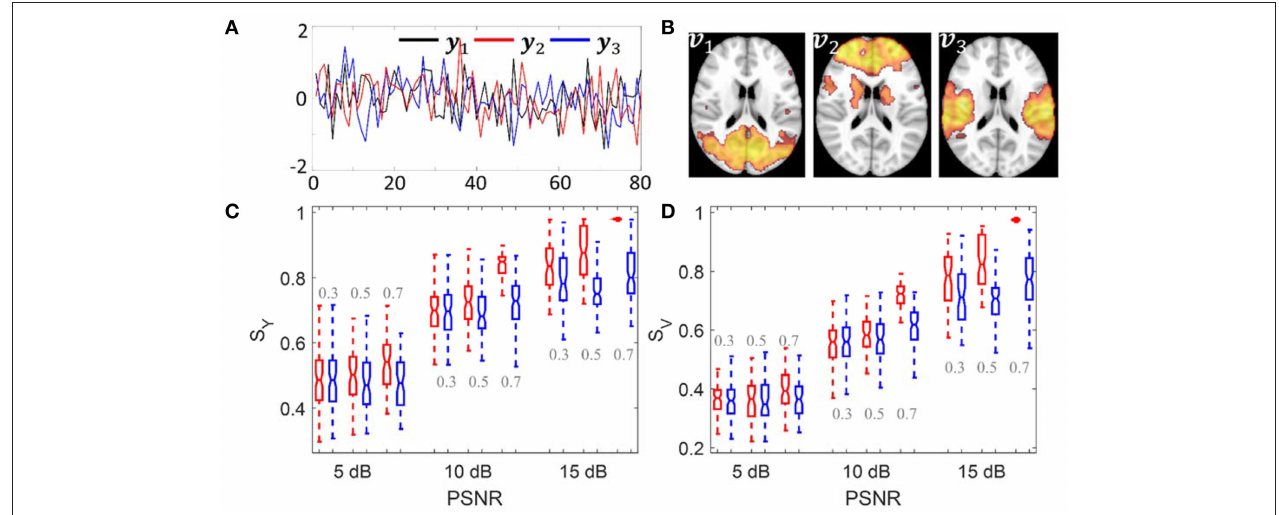
FIGURE 3 | Simulation 1: Comparison of sPCA and PCA. (A) Simulated principal component scores Y = [ y 1 , y 2 , y 3 ]. (B) The spatial maps V = [ v 1 , v 2 , v 3 ] corresponding to the scores with 70% voxels having zero values. Simulated data were generated 100 times with PSNR as 5 dB, 10 dB and 15 dB and sparsity level as 0.3, 0.5, and 0.7. (C) Boxplot for the similarity value with true principal component scores S Y . (D) Boxplot for the similarity value with true spatial maps S V . The boxplot for sPCA is shown in red and for PCA in